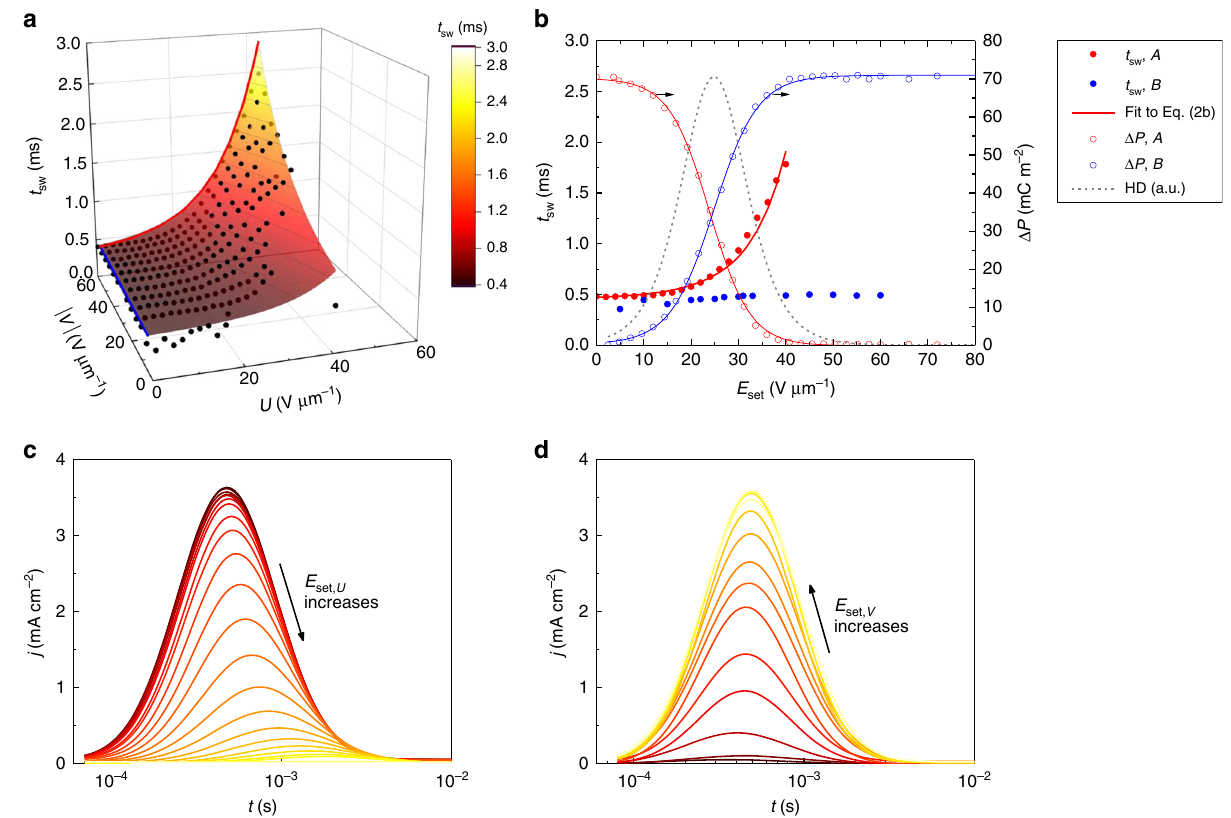
Fig. 6 Switching kinetics of different parts of the Preisach distribution. a Switching time dependence on the Preisach coordinates of a BTA device (measured at a constant applied fi eld). Experimental values (black circles) were obtained using the measurement procedure from Fig. 5 at T = 55 °C and fi tted to bivariate Eq. (5) (see Supplementary Table 2 for fi t parameters). b Switching time t sw, k (full circles) and switched polarization (open circles) plotted vs. the setting fi eld E set for A (red) and B (blue) measurement modes. The t sw values have been chosen as the time when the experimental switching current transients — panel c for case A and panel d for case B — reach their